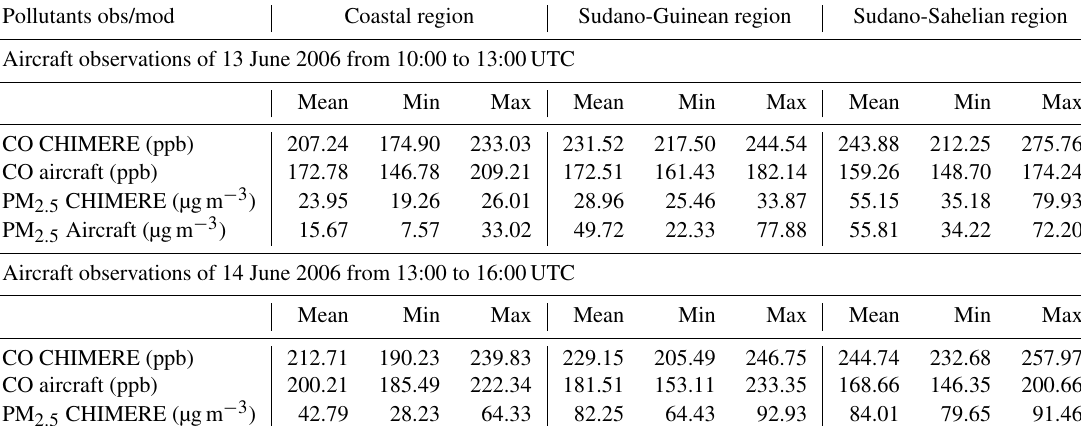
Table 1. Range of 2min average modeled and observed concentrations of CO (ppb) and PM 2 . 5 (µgm − 3 ) in the PBL (altitude lower